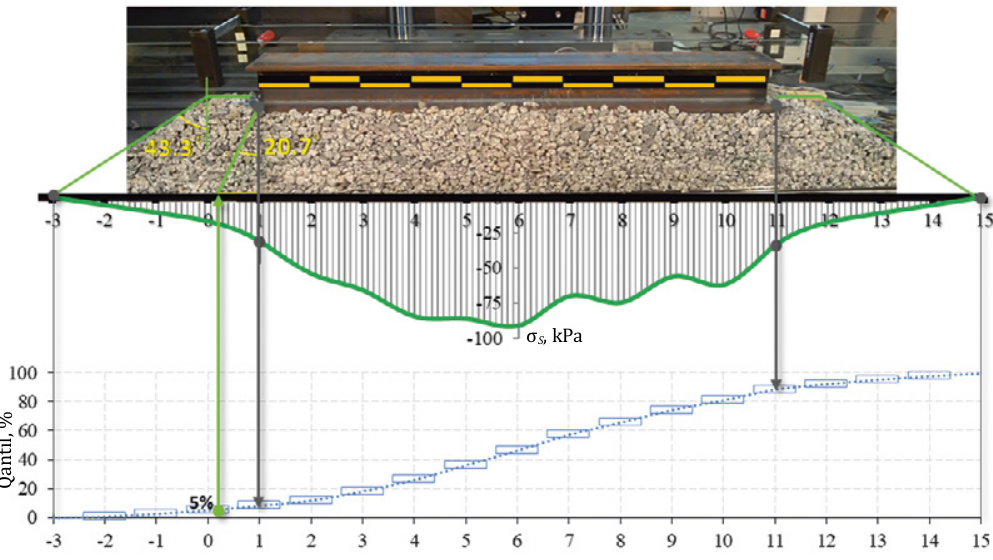
Figure 7. The angle of load distribution after the action of vibration loading on the ballast in cycle No.